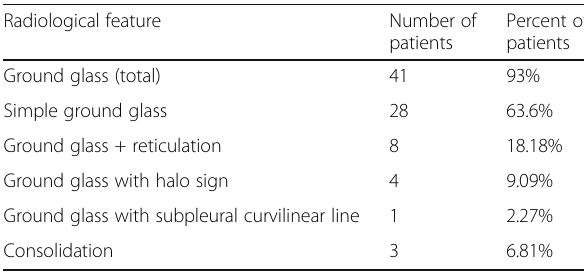
Table 2 showing various radiological features Radiological feature Number of